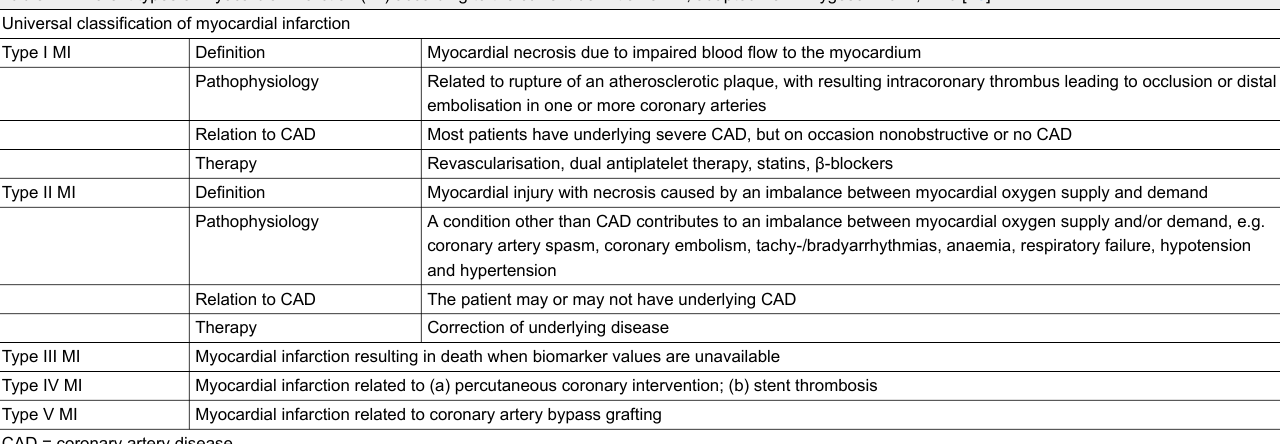
Table 1: Different types of myocardial infarction (MI) according to the current definition of MI; adapted from Thygesen 2012, EHJ [10]. Universal classification of myocardial